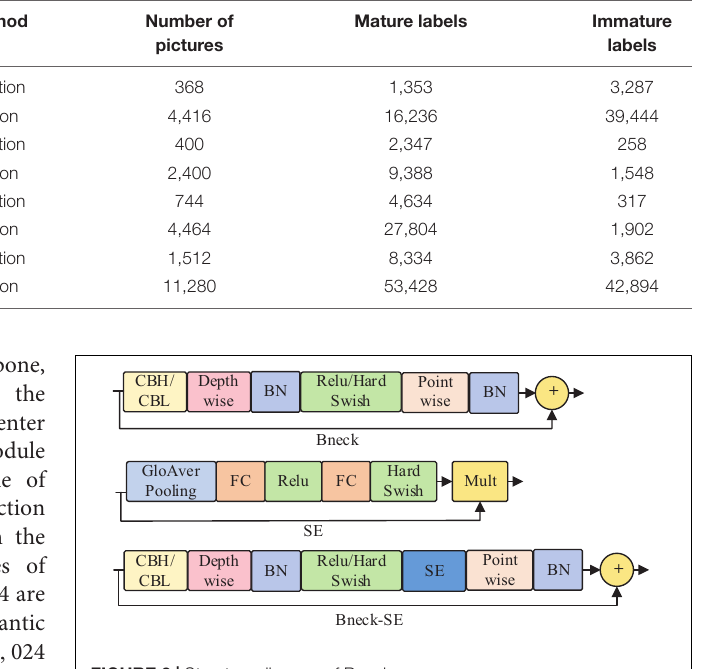
FIGURE 3 | Structure diagram of